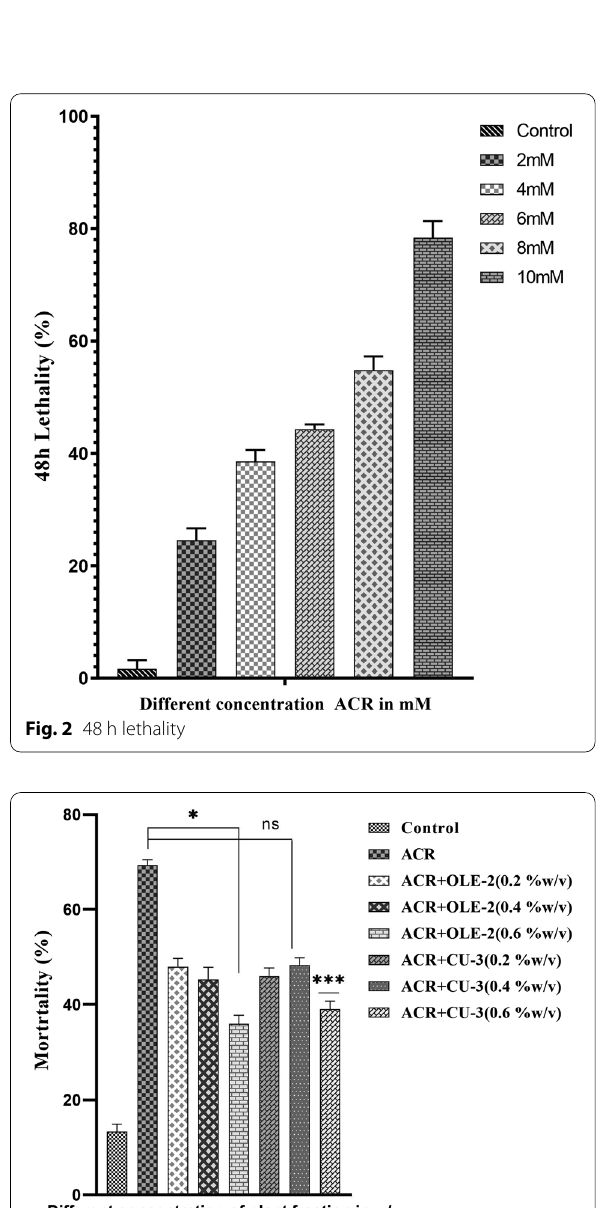
Fig. 3 Neuroprotective effective OLE-2 and CU-3 plant fractions on ACR-induced mortality of flies; Treatment group shows a significant increase of survivorship after 48 h of ACR (8 mM) exposure; Significance analysed by a one-way ANOVA; Error bar represents the Mean SD. The p values *p < 0.05 and ***p < 0.0001 were considered ± as